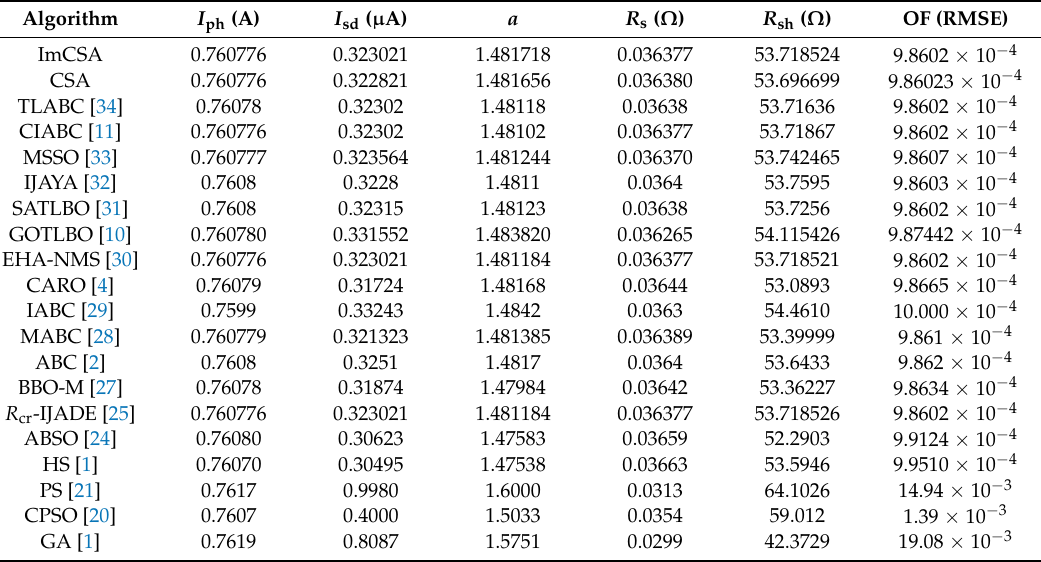
Table 2. Comparison among various parameter estimation algorithms for the SDM of RTC France silicon solar cell.